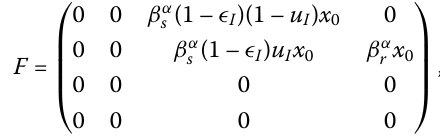
The reproduction number of the full model (1), R 0 is calculated as follows. The